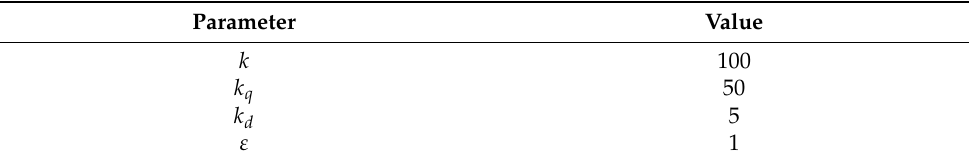
Table 2. Control gains for nonlinear controller.